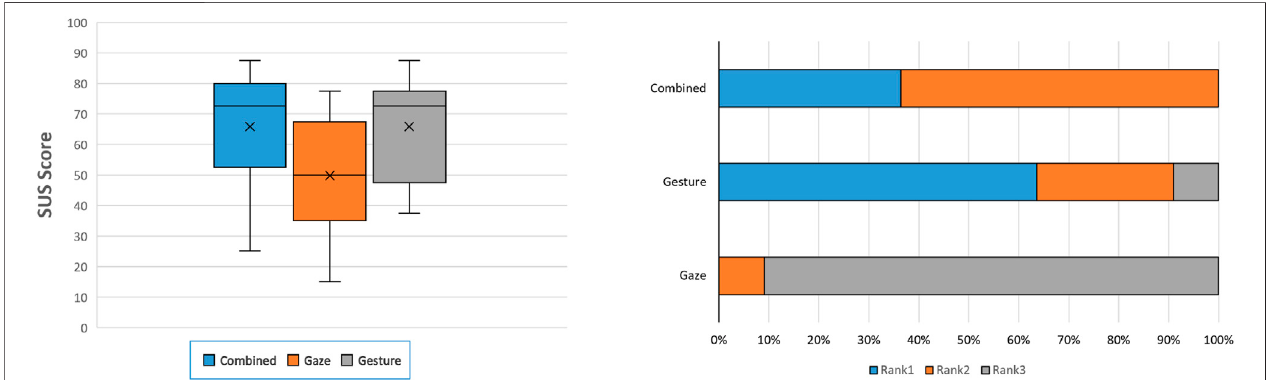
FIGURE 12 | (A) SUS questionnaire results (score of 68 considered average) and (B) Participants rankings of interfaces.